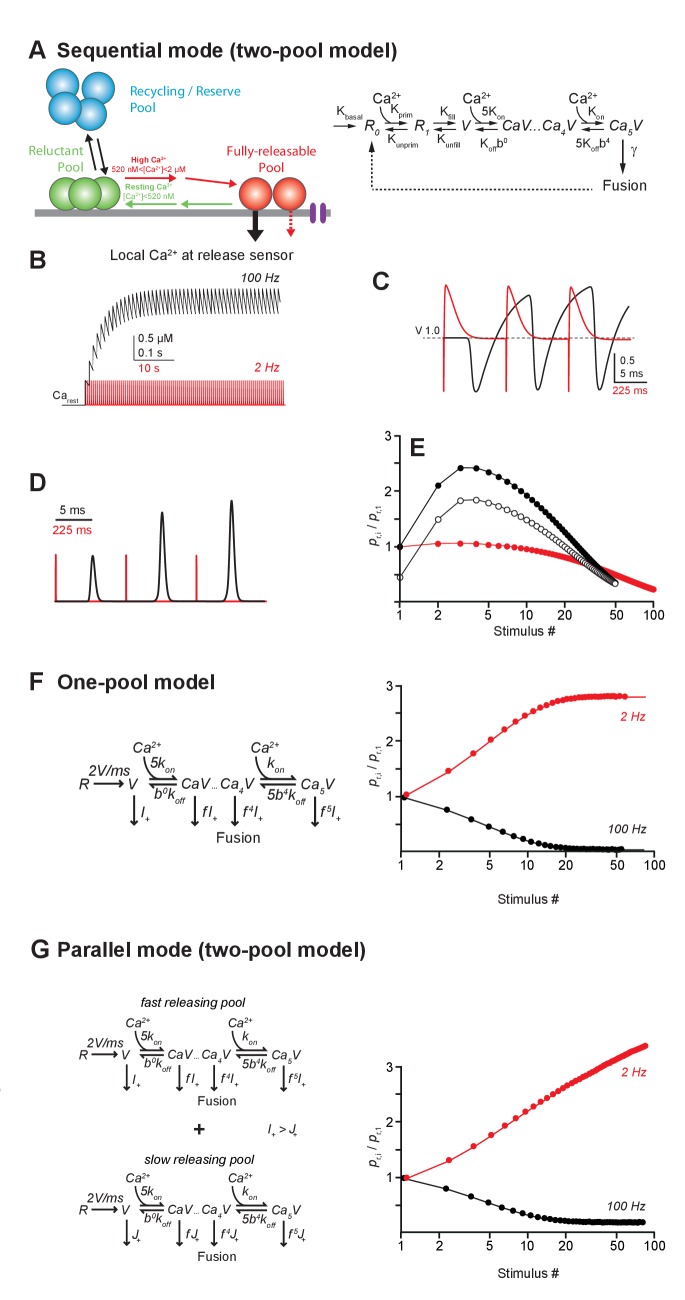
Models of LFD and short-term facilitation. (A) Left, scheme illustrating the sequential model of Ca2+ binding and release at the PF-PC synapse. Voltage-dependent calcium channels are represented in purple.Right, in the corresponding mathematical model the recycling/reserve pool is contained only implicitly by restoration of the reluctant pool (R0+R1) from fused SVs (dashed arrow) and via a basal refilling rate (kbasal). Therefore, this model is referred to as sequential ‘two-pool’ model. During high-frequency stimulation, the residual Ca2+ increases, resulting in recruitment of SVs from the reluctant pool into the fully-releasable pool, that is, a temporal increase in the fully-releasable pool that enables short-term facilitation (red arrow). The residual Ca2+ generates an additional moderate, short-lasting facilitation due to slow unbinding from the release sensor (dashed red arrow). During low- frequency activation at 2 Hz, the residual Ca2+ drops back to resting level between stimuli and SVs recruited to the fully-releasable pool return to the reluctant pool (green arrow). (B) Simulated amplitudes of residual Ca2+ during high- (100 Hz, black) or low-frequency (2 Hz, red) activation starting from a resting Ca2+ (Carest) level of 50 nM. (C) Fraction of Ca2+ unoccupied SVs in the fully-releasable pool (V) of the release sensor during the initial three activations of a 100 Hz (black) or 2 Hz (red) activation train. Note that during the first three stimuli at low frequency, the fully-releasable pool relaxes to its initial (V = 1, i.e. 100%) from a transient overfilling (V > 1) prior to the next pulse. The fully-releasable pool continues to increase in size during high-frequency activation due to the build-up of residual Ca2+ and continuous recruitment of reluctant vesicles (cf. B). (D) Transmitter release rates during three stimuli at high (black) or low frequencies (red), normalized to the first release event (E) Paired-pulse ratios (PPRs) calculated as the ratio of release probabilities in the i-th (pr,i) and the first pulse (pr,1) during 100 Hz (filled black) or 2 Hz (red) stimulation. Open circles show PPRs during 100 Hz activations started in a previously depressed state. (F) Left, one-pool model of Ca2+ binding and release according to Wölfel et al., 2007 consisting of the ‘allosteric’ sensor model (Lou et al., 2005) supplemented with a reloading step of 2 SVs/ms. Right, in contrast to our experimental findings, this model generates low-frequency facilitation and high-frequency depression. (G) Left, as in F but for two parallel, non-interacting pools of SVs differing in their release rate constants thereby generating a ‘fast releasing pool of SVs’ (release rate I+ as in F) and a ‘slowly releasing pool of SVs’ (release rate J+<I+ as in F, Wölfel et al., 2007). Both models are restored via Ca2+ independent reloading steps of 2 SVs/ms. Right, note that similar to the model in F, this simulation generates a high-frequency depression and a low-frequency facilitation. Models in F and G fail to reproduce our experimental findings.